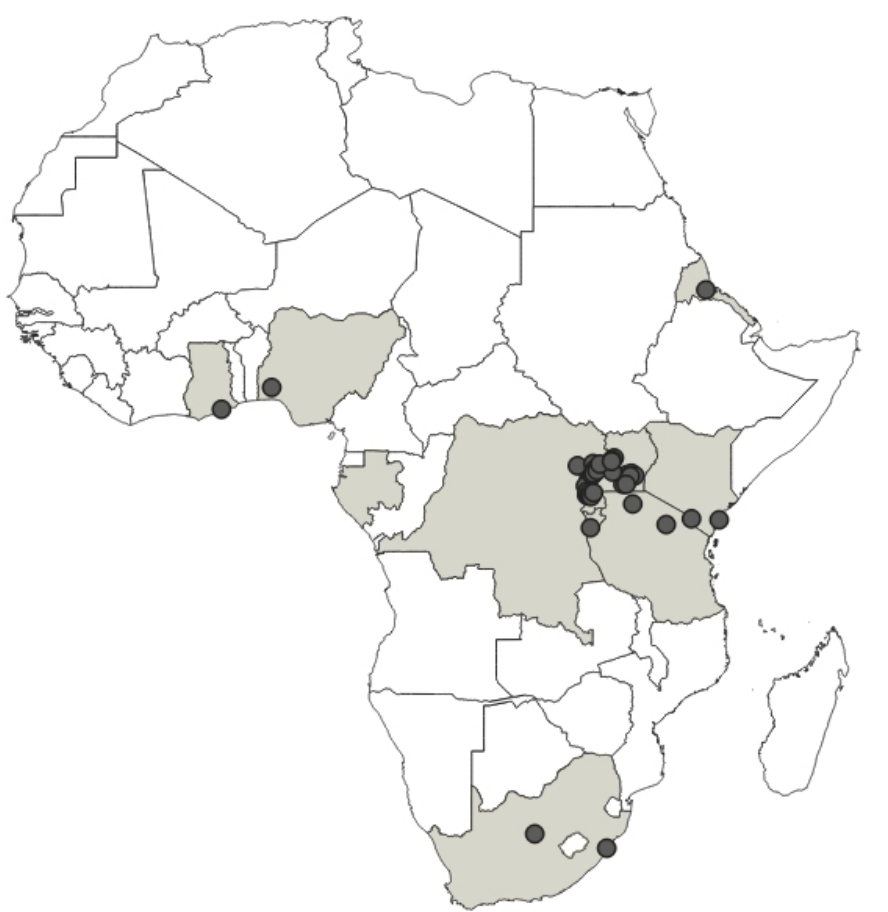
Figure 52. Known distribution of Phonoctonus nigrofasciatus Stål, 1855.